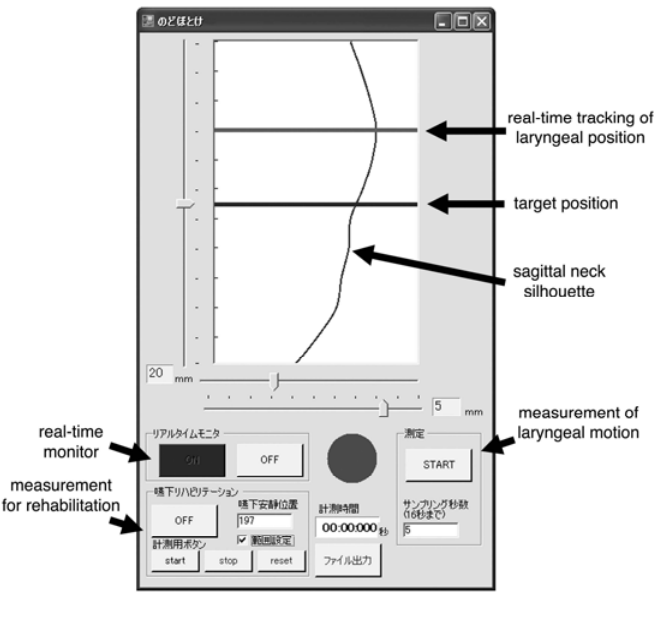
Figure 23. Visual feedback subsystem of the SFN -2 for application of laryngeal elevation exercises to patients with dysphagia. This subsystem provides a sagittal neck silhouette and laryngeal position on the computer screen in real